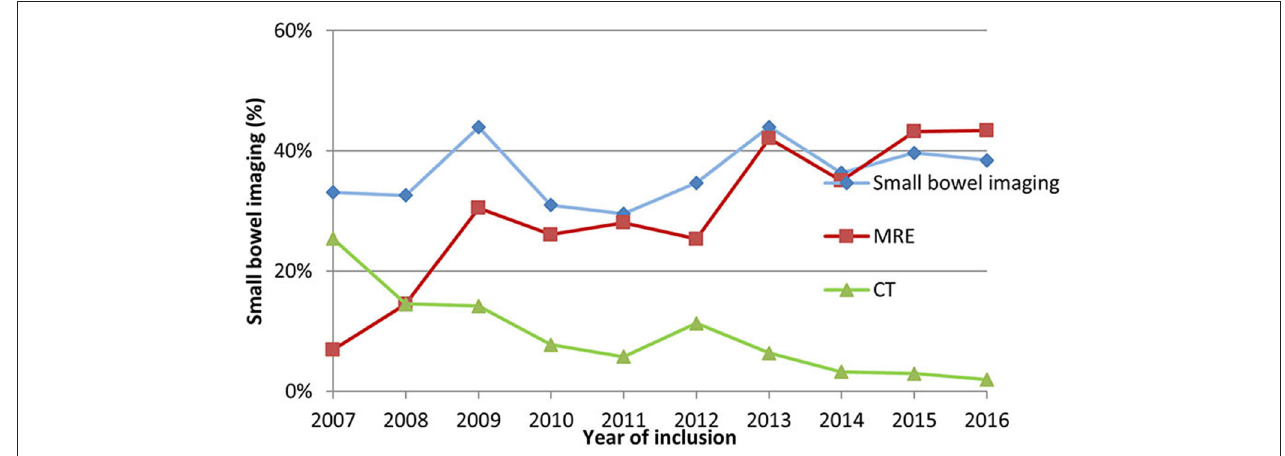
FIGURE 2 | Rate of small bowel imaging, MRE and CT within the HUPIR cohort from 2007 to 2016.